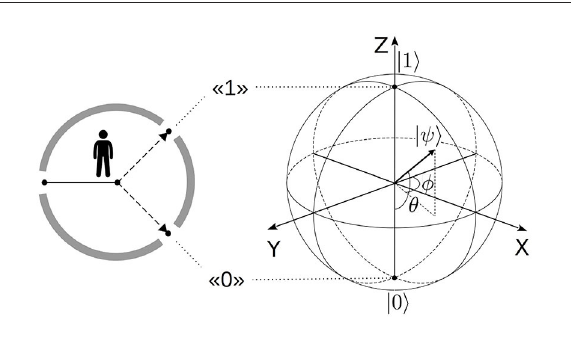
FIGURE1 Qubit model of context representation (Surov, 2021). Individual facing a two-way alternative represents all available information (context), shown by gray bars, relative to this decision by qubit ψ state (Equation 1). All such states belong to a Poincaré | i (Bloch) sphere, built on the poles corresponding to basis alternatives 0 , 1 , as shown on the right. The sphere functions | i | i as cognitive-semantic space, subjectively